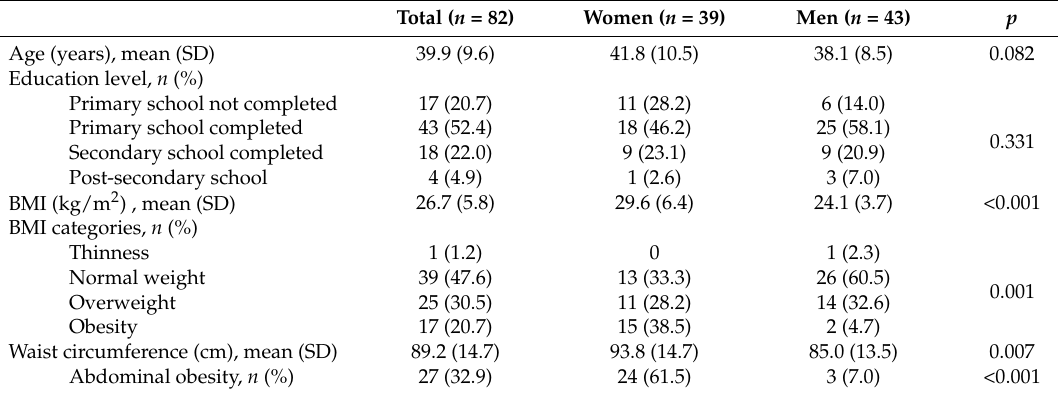
Table 1. Characteristics of the study sample, overall and by